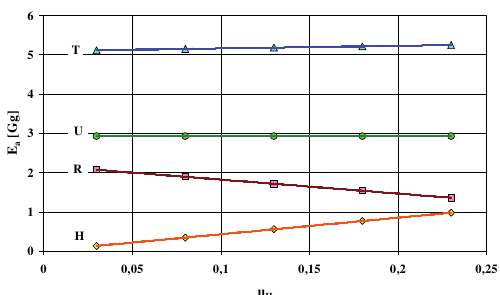
Fig. 11. Dependence of the national annual emission of particulate matter PM10 from tribological elements of passenger cars upon the road length travelled under the following model traffic conditions: U – urban, R– rural, H – on highways and expressways as well as T – under all conditions